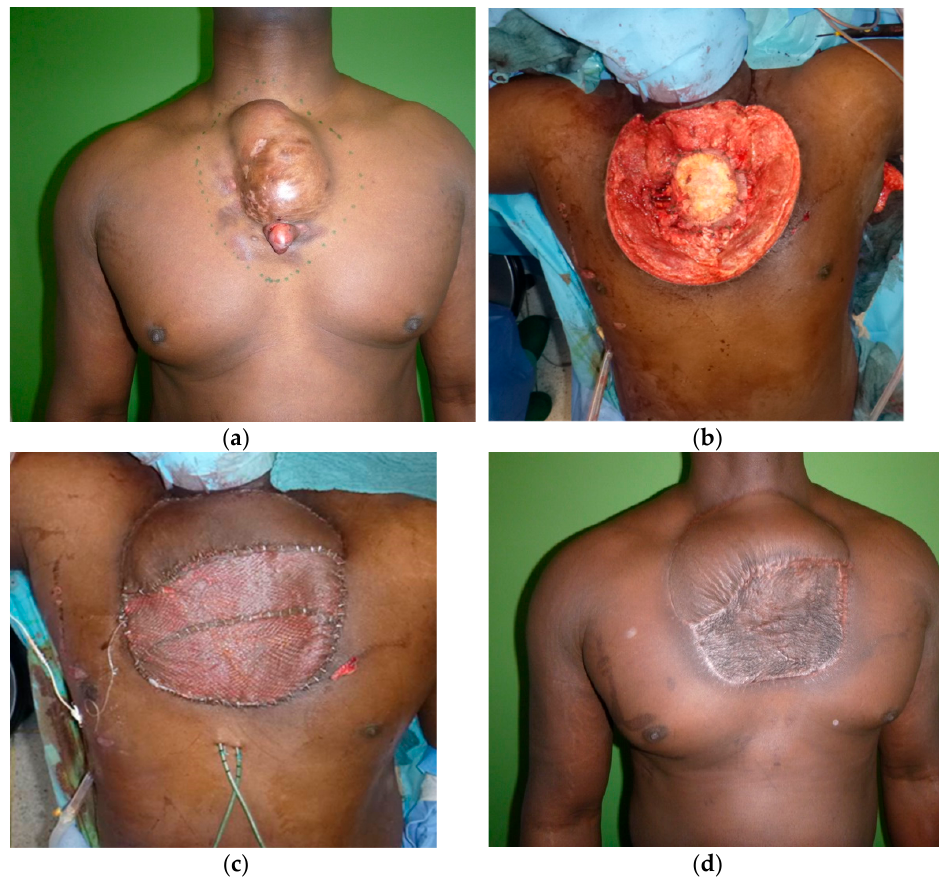
Figure 1. This figure illustrates a complex case of DFSP with infiltration to the sternum. ( a ) The initial appearance of the tumour prior to radiotherapy. ( b ) Defect after tumour resection with 3 cm margins and partial sternum resection. The defect measured 22 × 20 cm. ( c ) Defect reconstruction was achieved by use of a free conjoined parascapular and latissimus dorsi flap, which was anasto ‐ mosed to the right internal mammary and vein in an end ‐ to ‐ end fashion [13]. ( d ) The result at 4 ‐ month follow ‐